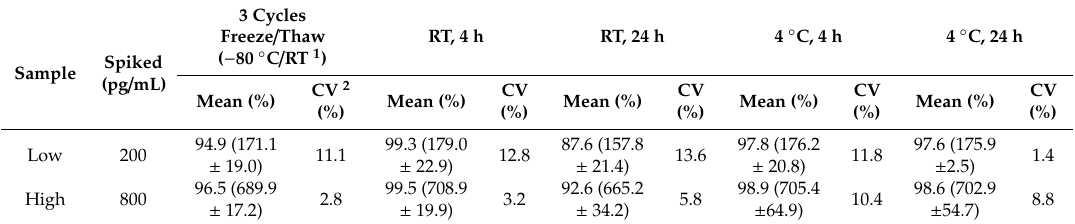
Table 3. Stability of OT spiked in dog